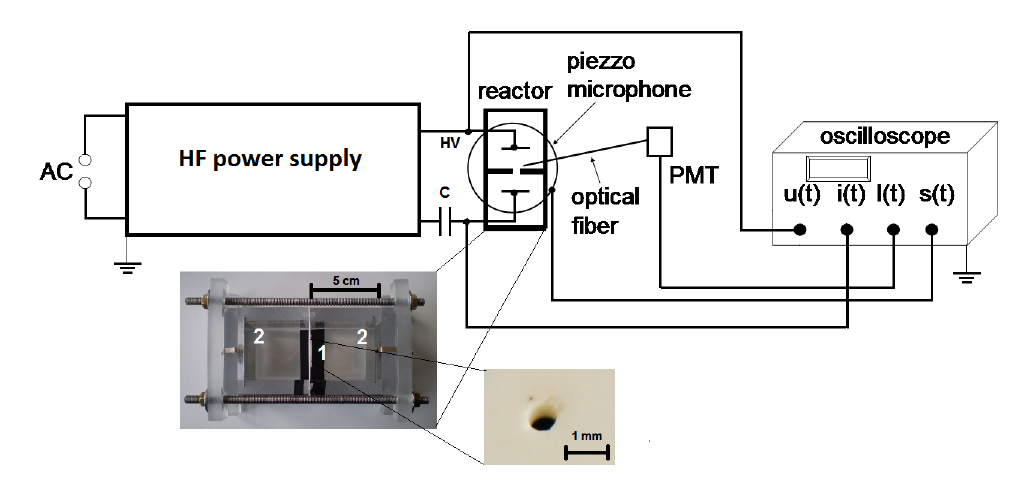
Figure 1: Simplified scheme of the pin-hole plasma reactor (1 – ceramic dielectric barrier with the pin-hole, 2 – planar electrodes) and its integration into the circuit with the high frequency HV source and the four-channel oscilloscope: u(t) – voltage, i(t) – current, l(t) – light, s(t) –